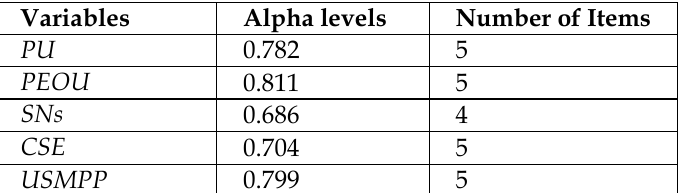
Table 2: Summary of alpha levels for the adopted and modified scales Variables Alpha levels Number of Items PU